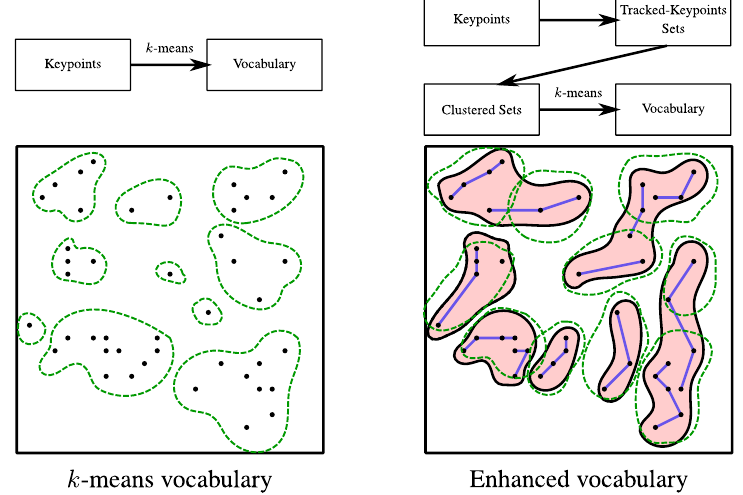
Figure 4. Differences between standard k -means vocabulary and our hierarchical vocabulary building process. k -means clusters directly in the feature descriptor space. Our enhanced vocabulary first groups by tracking, then clusters tracked key-point sets into classes, and finally clusters with a k-means within each of the found classes to create the final visual